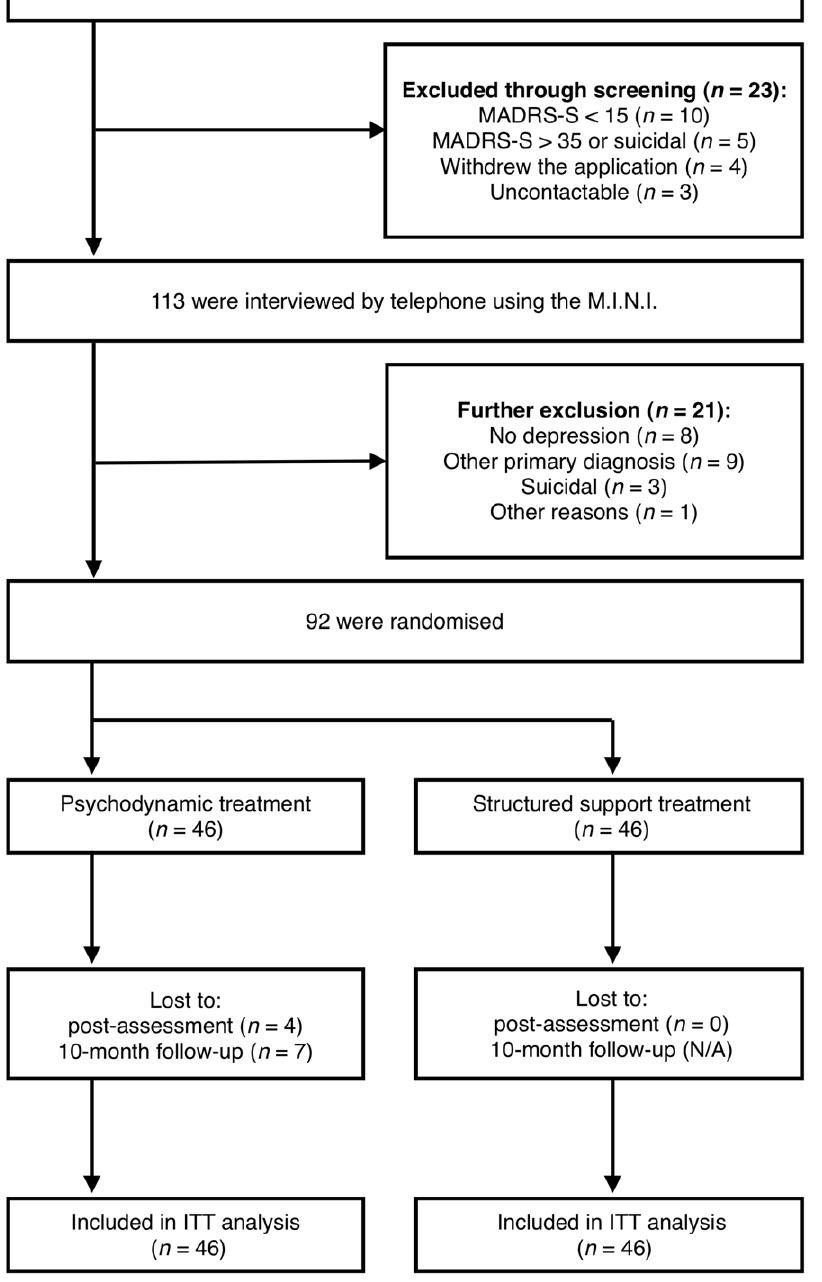
Figure 1. Participant flow and reasons for exclusion. Abbreviations: MADRS-S: Montgomery-A˚sberg Depression Rating Scale-Self-rated version; M.I.N.I.: Mini-International Neuropsychiatric Interview; ITT: Intention-to-treat.